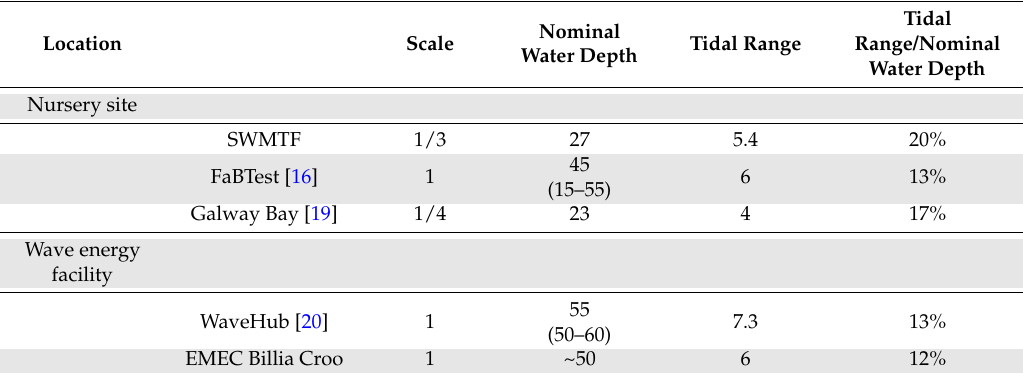
Table 8. Tidal variations compared to water depth at different wave energy